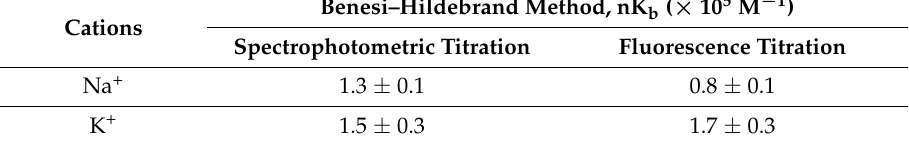
Table 3. Parameters for the interaction of ligand 3 with G-quadruplex 22HT determined using the Benesi–Hildebrand method from absorption and fluorescence titration data (K b —binding constant, n—number of bound ligand molecules per G-quadruplex).